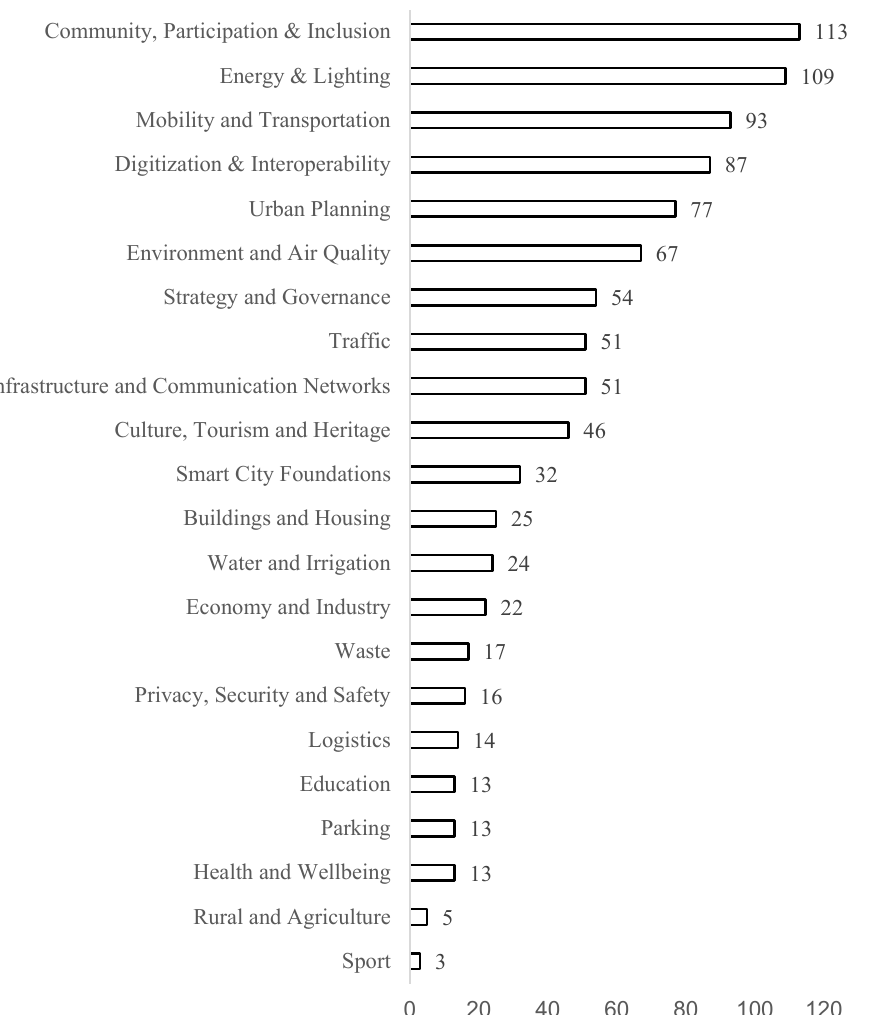
Figure 6. Distribution of the smart city initiative results by category.